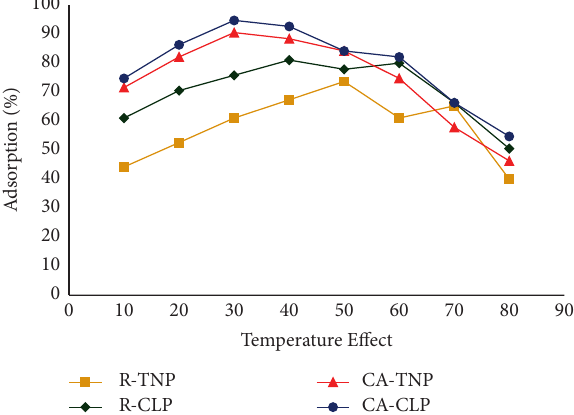
Figure 10: Effect of temperature on adsorption. Experimental conditions: temperature range 10 to 80 ° C, conc. � 25ppm, volume � 25mL, adsorbent dose � 0.6g, contact time � 30 min, initial pH � 5, final pH: R-TNP � 5, R-CLP � 4.5, CA-TNP � 4.0, and CA-CLP � 4.0, and agitation speed 100